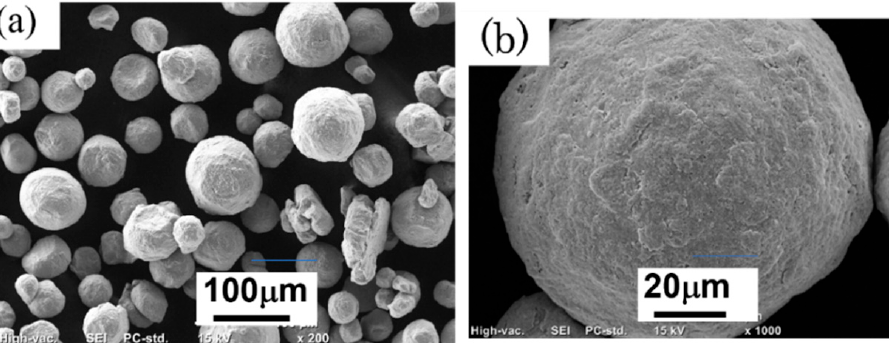
Figure 4. SEM images of Inconel 718 PA powder after ball milling for 30 min: ( a ) Morphology of powder particles; ( b ) Detailed surface morphology of one powder particle.